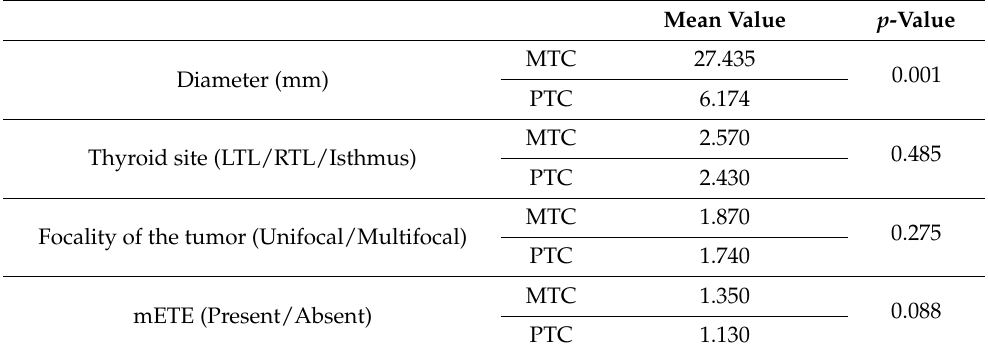
Table 3. Pathological characteristics of the TCTs’ MTC components compared to PTC components (Chi-squared